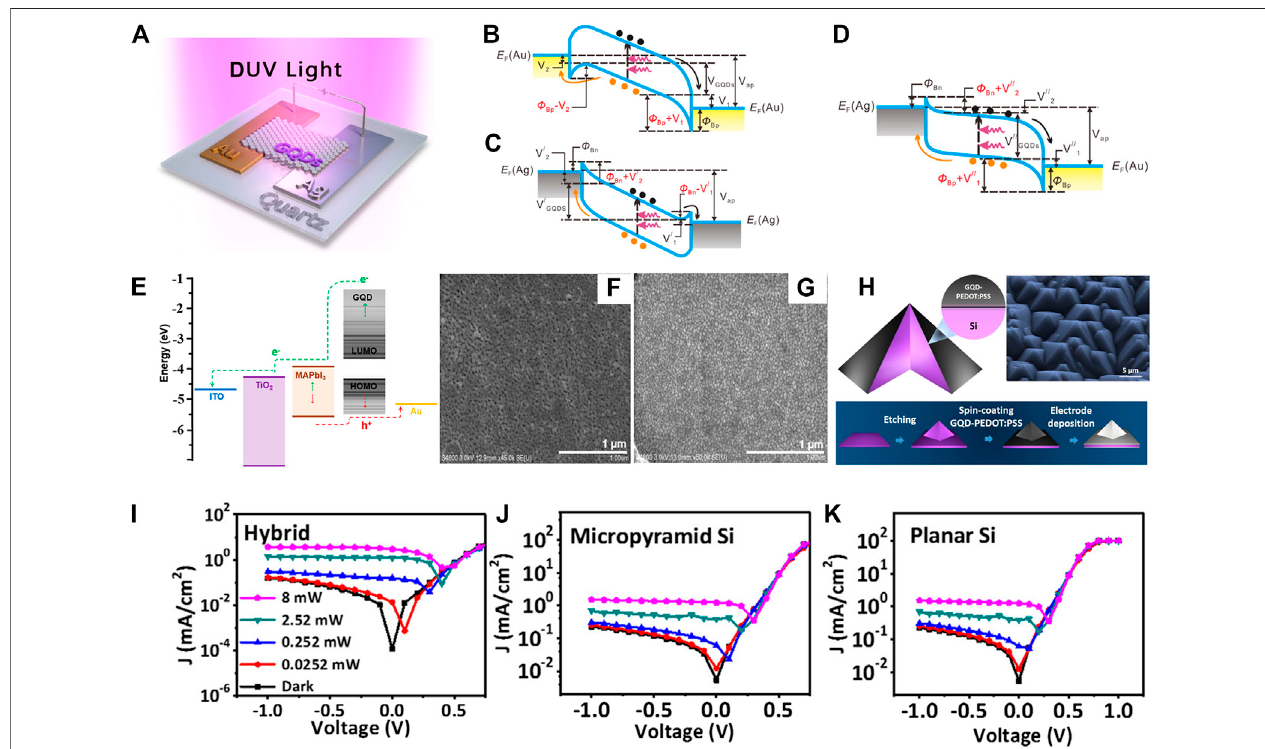
FIGURE 3 | (A) Schematic of GQD-based PDs with asymmetric electrodes. (B – D) Schematic diagram of energy band of GQD-based PD with (B) Au/Au, (C) Ag/ Ag, and (D) Ag/Auelectrodes, respectively. (E) Schematic ofenergydiagram and carrier transportation mechanism of the GQD/MAPbI 3 PD. SEM images of (F) MAPbI 3 fi lmand (G) GQD/MAPbI fi lm. (H) Thestructure,SEMimage,andthefabricationprocedureofthedevice.I-Vcurvesof (I) thehybrid, (J) micropyramidSi,and (K) planar 3 Si PDs in the dark and under 532 nm incident light with different power. (A – D) Reprinted with permission from ACS Nano, 2015, 9, 1561-1570. Copyright 2015 American Chemical Society. (E – G) Reprinted with permission from ACS Appl. Electron. Mater., 2020, 2, 230-237. Copyright 2020 American Chemical Society. (H – K) Reprinted with permission from ACS Nano, 2017, 11, 4564-4570. Copyright 2017 American Chemical